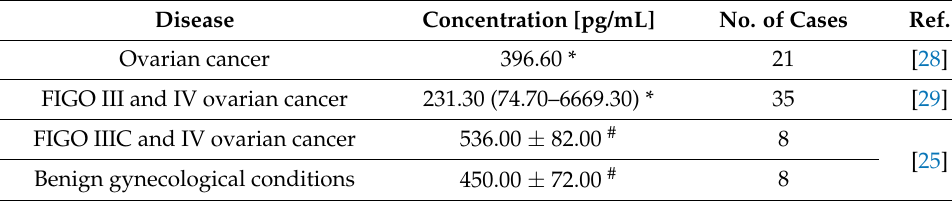
Table 5. Concentrations of interleukin 8 (IL-8) in ascites. Disease Concentration [pg/mL] No. of Cases Ref. Ovarian cancer 396.60 * FIGO III and IV ovarian cancer 231.30 (74.70–6669.30) * FIGO IIIC and IV ovarian